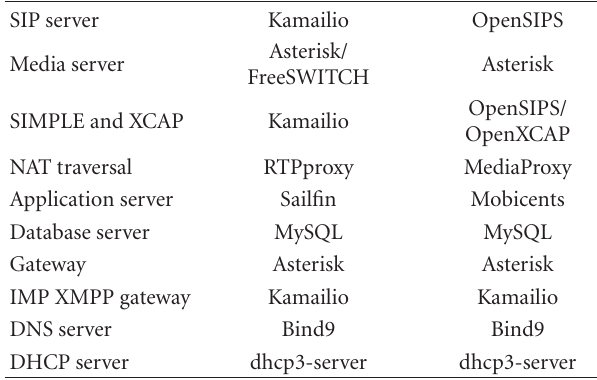
Table 4: Proposed